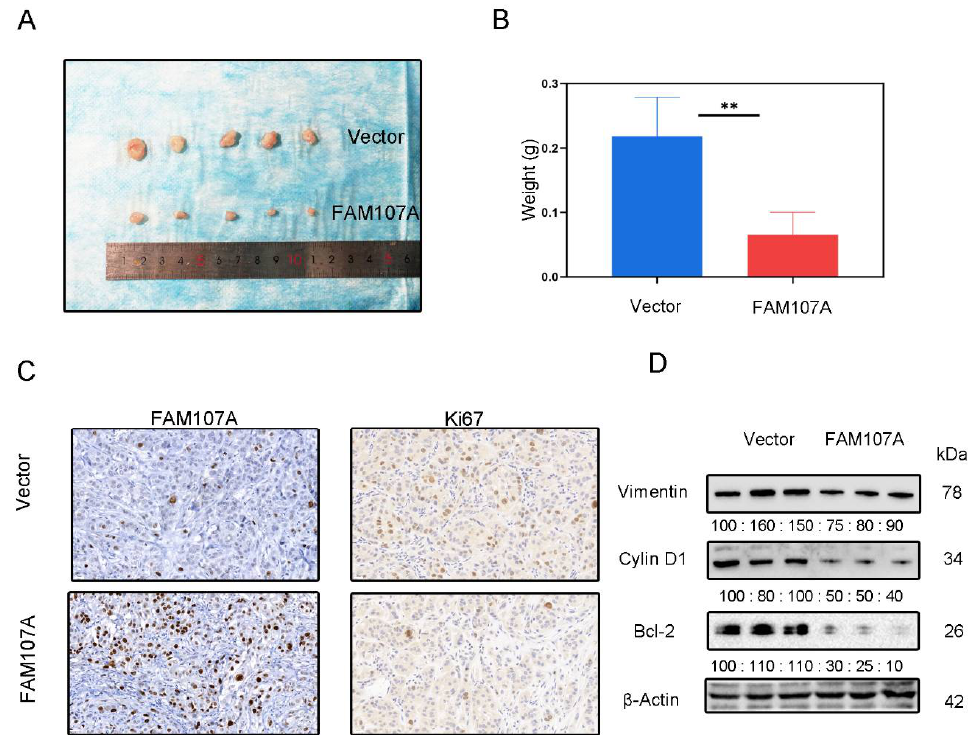
Figure 9. Overexpression of FAM107A inhibited the growth of PCa cells in vivo. ( A ) Comparison of tumor model sizes in the pc-Vector pc-FAM107A group. ( B ) Comparison of the weight of tumors in the pc-Vector pc-FAM107A group. ( C ) Ki67 and FAM107A expression in tumor tissues was detected